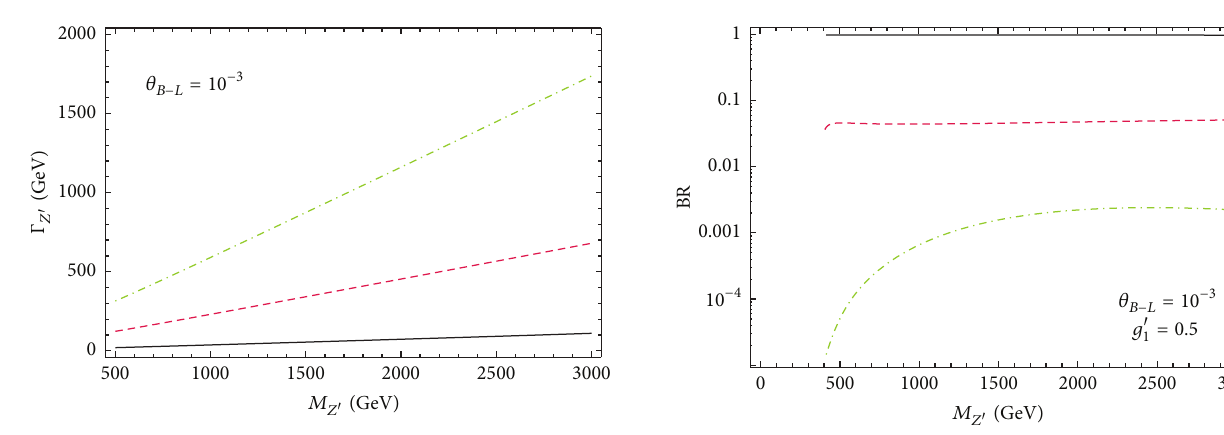
Figure 2: 𝑍 󸀠 width as a function of 𝑀 𝑍 󸀠 for fixed values of 𝑔 󸀠 1 . Starting from the bottom, the curves are for 𝑔 󸀠 1 = 0 . 2 , 0 . 5 , 0 . 8, respectively.